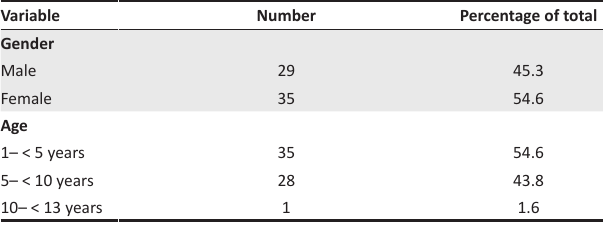
FIGURE 1: Patient population. TABLE 1: Demographic characteristics.